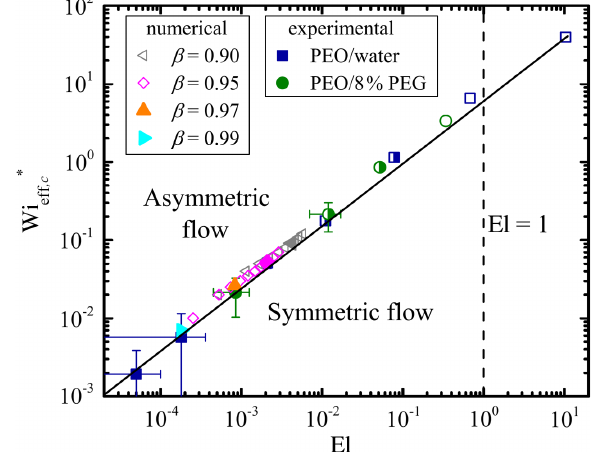
FIG. 12. Wi (cid:3) as a function of El. For experiments, closed eff ;c symbols represent steady spiral instabilities, half-closed symbols represent unsteady spiral vortex instabilities, and open symbols represent elasticity-dominated asymmetries. For numerical results, open symbols represent constant Wi , while closed symbols eff represent constant El simulations. The dashed line marks El ¼ 1 . ¼ 6 El 0 . 8 . (Note that error Power-law fit through the data is Wi (cid:3) eff ;c bars on the two lowest El experimental data points extend beyond the boundaries of the